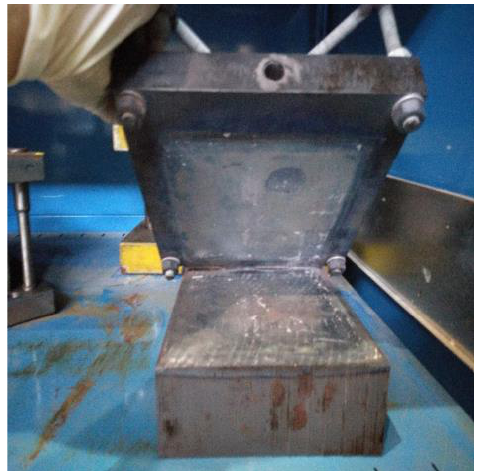
Figure 2. Heated blocks used for bainitic quench.